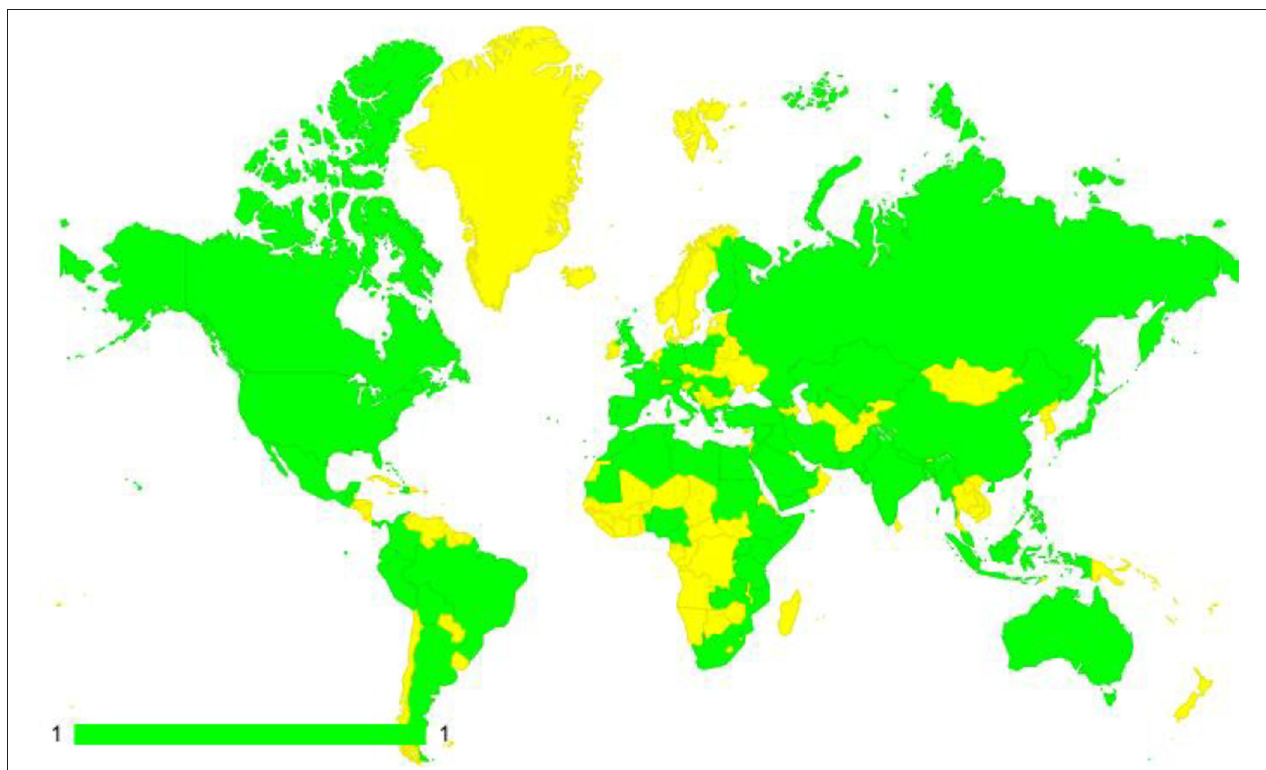
FIGURE 3 | A geo map of the 84 countries from which collaborators have registered for the GNS-I study (marked in green color). The yellow color represents countries that are not yet